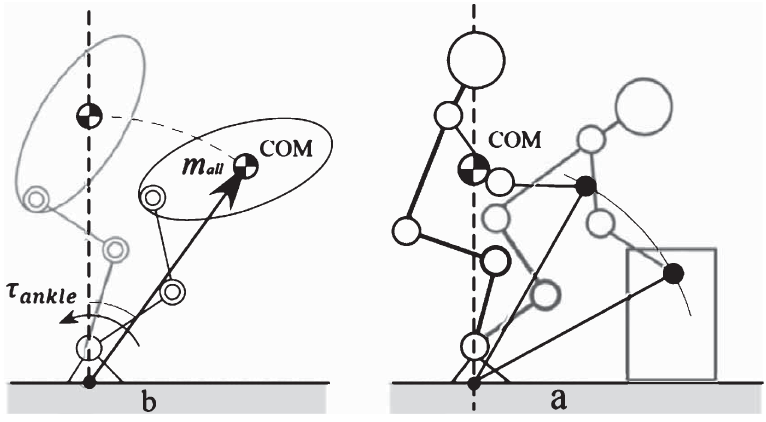
Fig. 4. a) 5DOF model of human body for lifting motion task, b) inverted pendulum equivalent model for the lifting task.